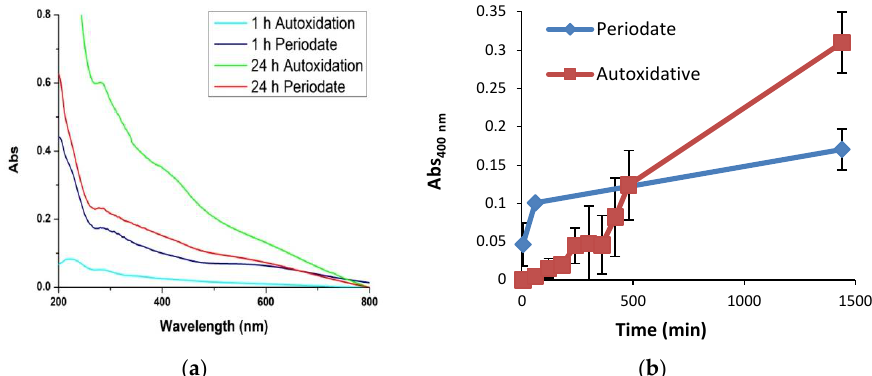
Figure 5. Kinetics of polydopamine (PDA) film formation: autoxidation vs . periodate. ( a ) Evolution of the ultraviolet–visible (UV–vis) spectra of PDA film formed by dopamine autoxidation or periodate-induced oxidation. ( b ) Time course of 400 nm absorption development for PDA film formed by dopamine autoxidation (red line) vs. periodate induced oxidation (blue line). Data are shown as mean ± standard deviation (SD) of three independent experiments.